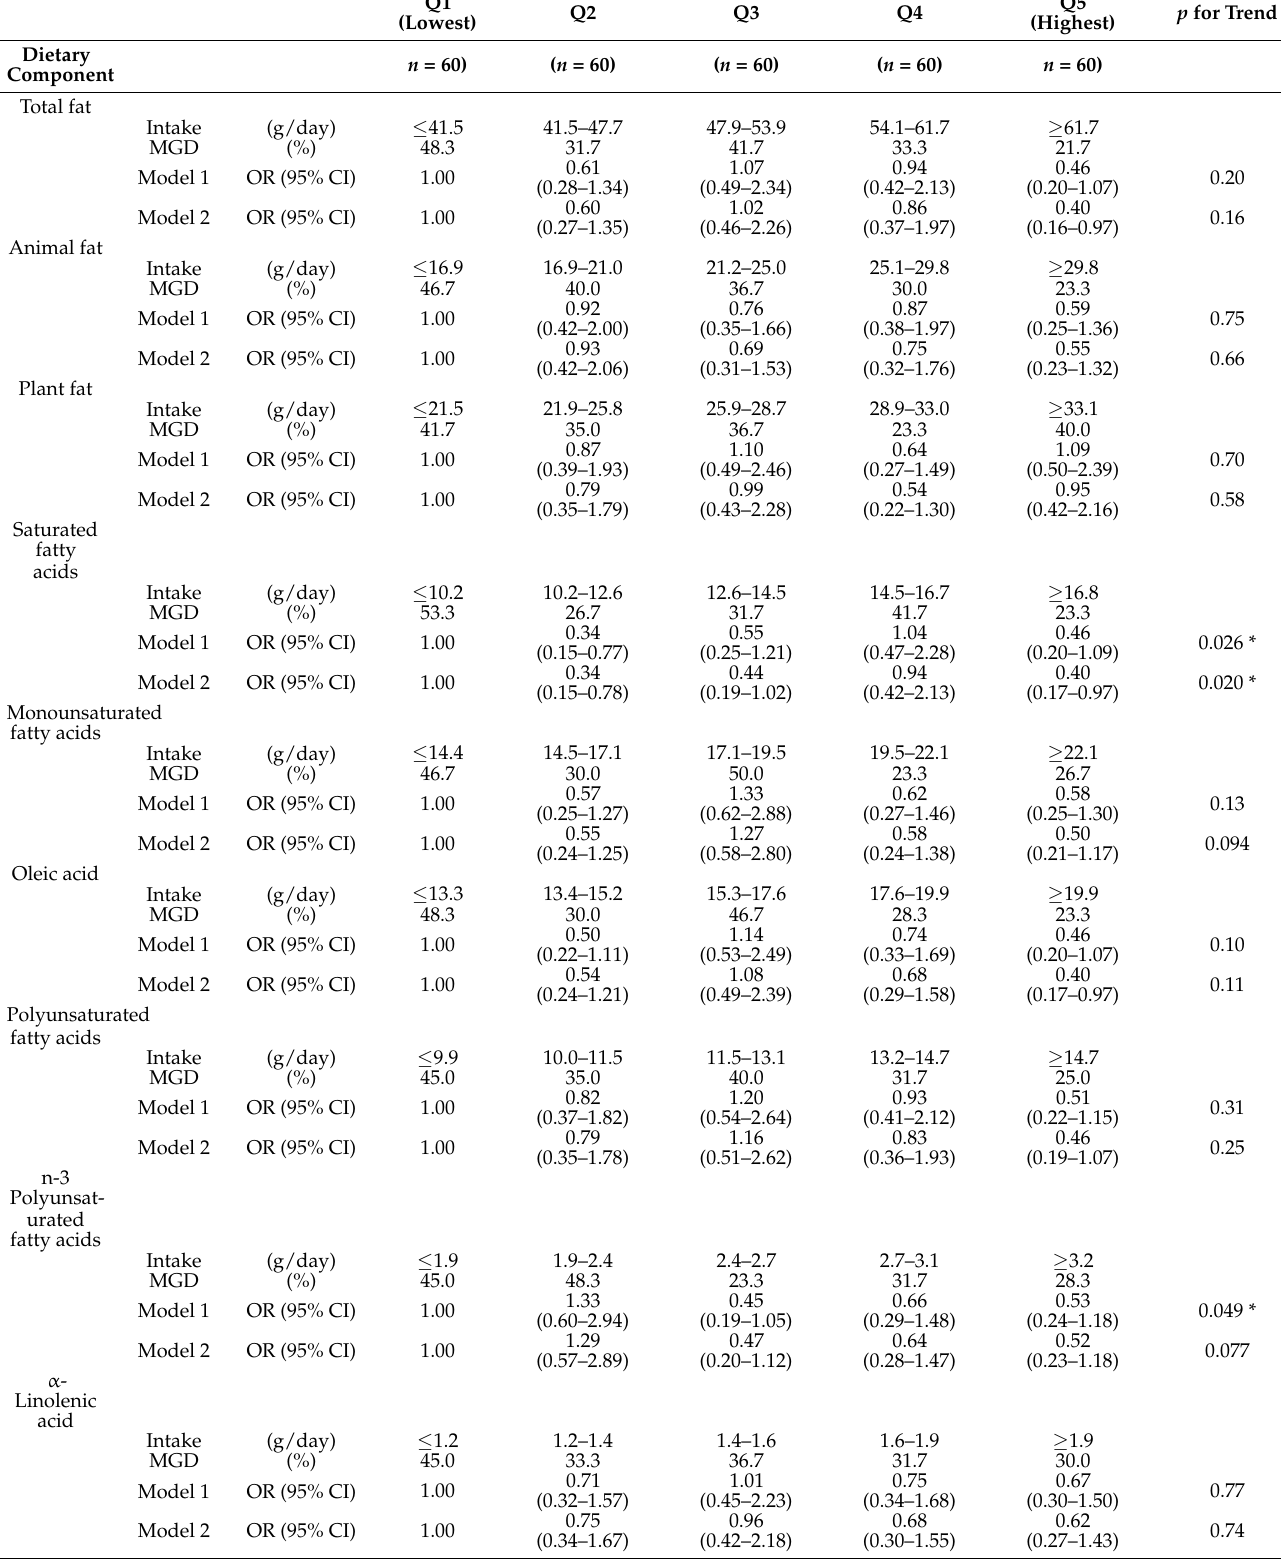
Table 4. Multivariate adjusted odds ratios (ORs) and 95% confidence intervals (CIs) for the prevalence of meibomian gland dysfunction (MGD) by quintile (Q) of intake of specific fats and vitamin D among adult subjects in the Hirado–Takushima